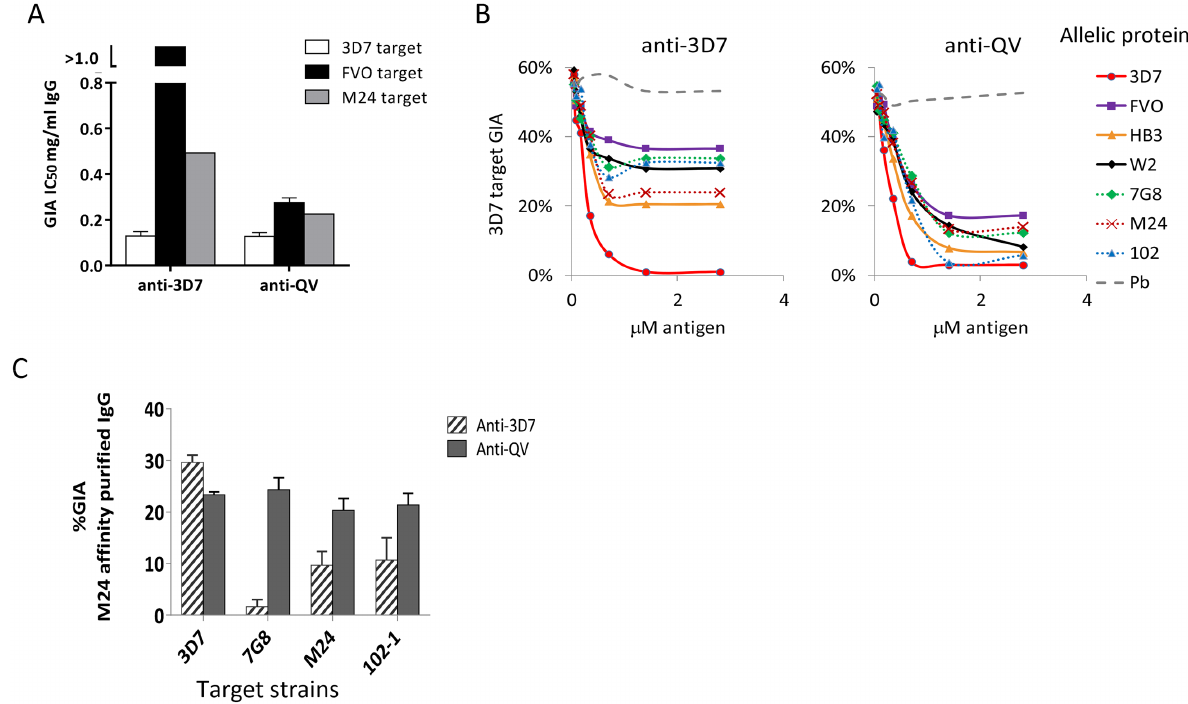
Figure 2. Quantification of broadly inhibitory antibodies. ( A ) IC 50 values against three target strains for the monovalent anti-3D7 and anti-QV IgG, affinity purified from pools of 3 rabbit sera, using a 3D7 AMA1 column (GIA in Fig. S2). ( B ) GIA reversal comparing the ability of AMA1 allelic proteins to reverse the inhibition of 3D7 parasite invasion by pools of anti-QV or anti-3D7 sera. P. berghei AMA1 was used as the negative control (Pb). The data is representative of 2 experiments. ( C ) GIA of pooled anti-3D7 and anti-QV IgG (3 rabbits each) that was bound and eluted from a M24 AMA1 affinity column and tested at 0.15 mg/ml against 3D7 or three non-vaccine parasite strains (7G8, M24 and 102-1). Mean + s.e.m from 3 experiments is shown.